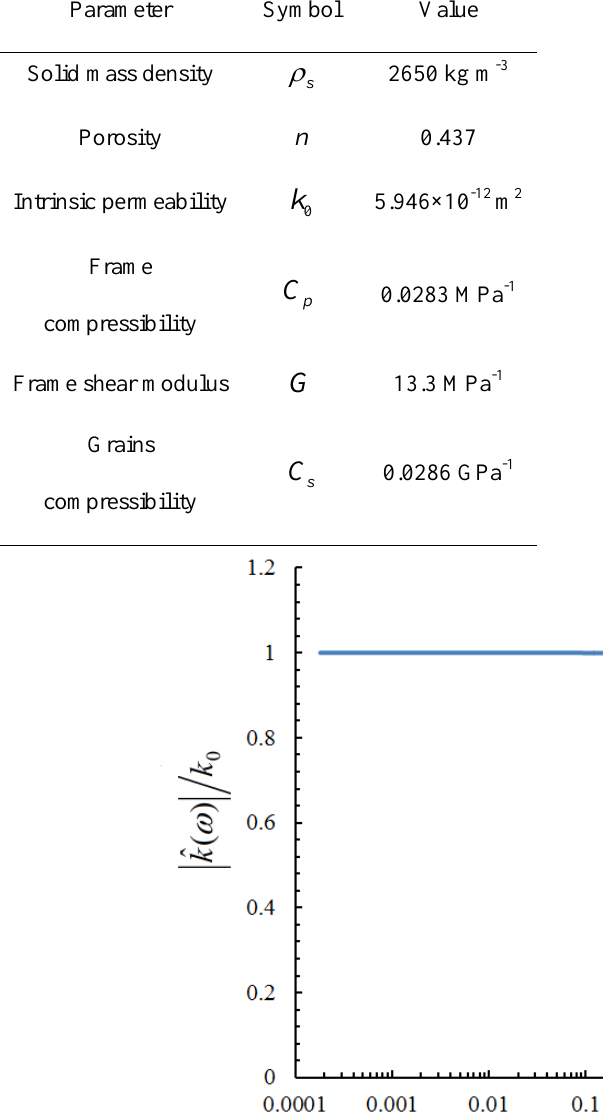
Table 1. Material properties of Sand.